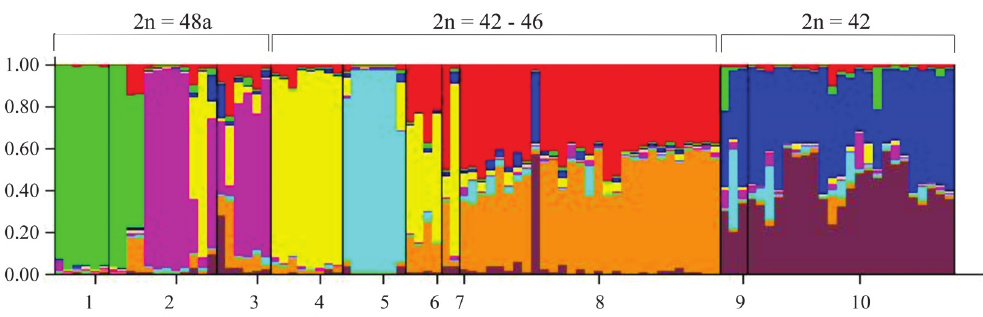
Figure 2 - Structure bars plot showing the eight genetic populations identified by the analysis. The numbers 1-10 correspond to the sample spots in Figure 1 and Table 1.